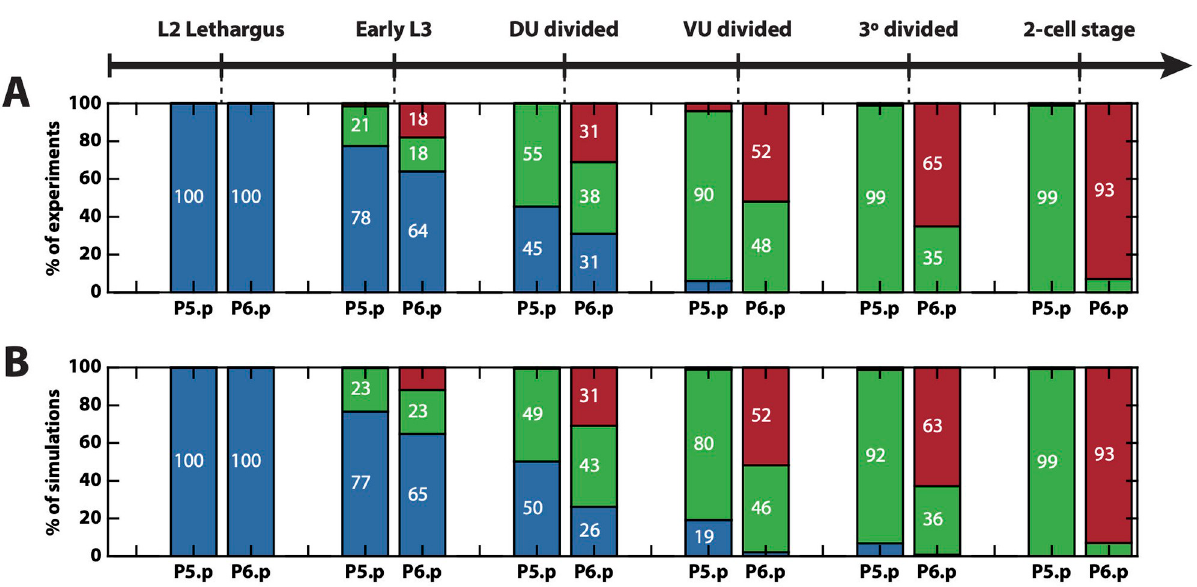
Fig 5. AC ablation fitting and validation. (A) Patterns observed when the AC is ablated at different developmental stages. (B) Mean simulated patterns for the different AC ablation conditions. Only proportions for P5.p and P6.p are available, which are presented in blue, green or red representing tertiary, secondary or primary fate,